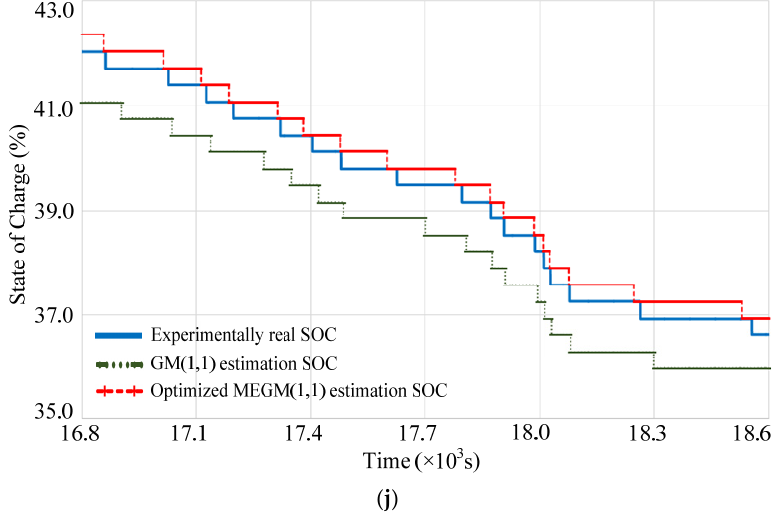
Figure 8. Verification results under the CLTC driving condition with initial SOC errors at the various temperatures: ( a ) SOC comparison among the experimental data, GM(1,1) and MEGM(1,1) estimation at − 10 °C; ( b ) the enlarged view of SOC in one cycle for the time range of 16.8 ks–18.6 ks at − 10 °C; ( c ) SOC comparison at 0 °C; ( d ) the enlarged view at 0 °C; ( e ) SOC comparison at 15 °C; ( f ) the enlarged view at 15 °C; ( g ) SOC comparison at 25 °C; ( h ) the enlarged view at 25 °C; ( i ) SOC comparison at 35 °C; ( j ) the enlarged view at 35 °C. Table 3. Estimation analysis for GM(1,1) and MEGM(1,1) after convergence under CLTC.